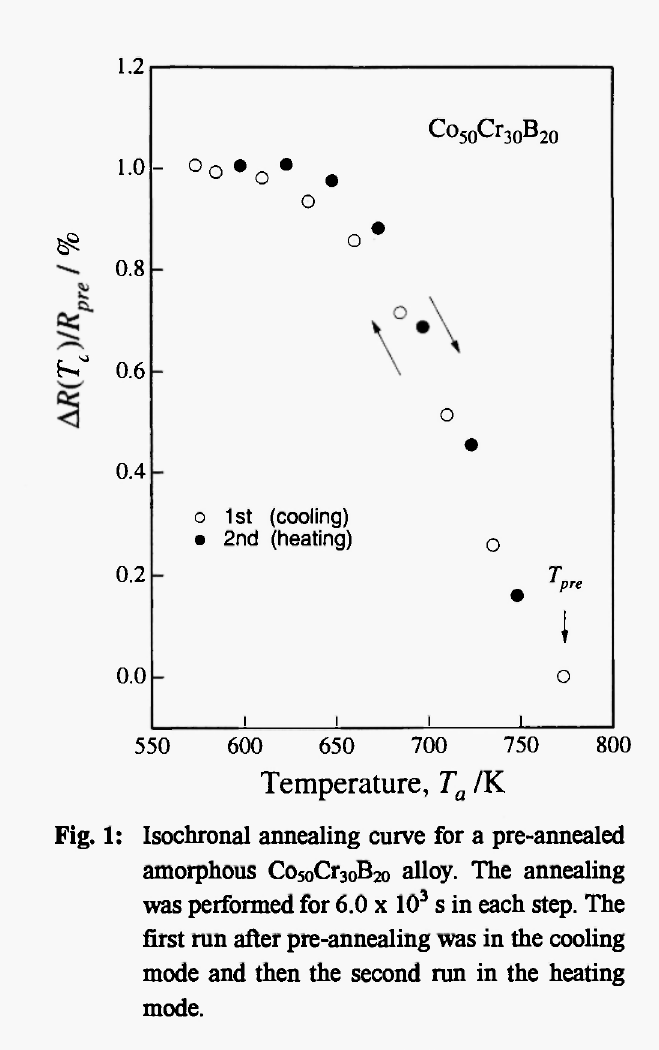
Fig. 1: Isochronal annealing curve for a pre-annealed amorphous Co5oCr 3 oB 2 o alloy. The annealing was performed for 6.0 χ 10 3 s in each step. The first run after pre-annealing was in the cooling mode and then the second run in the heating mode.